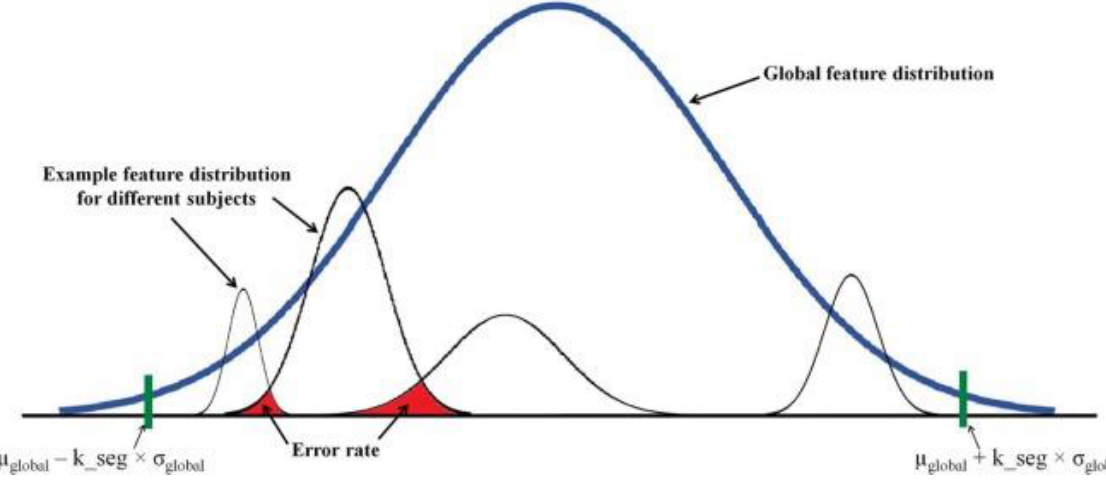
Figure 4. An example of key generation process from the global feature distribution of an electrode for a